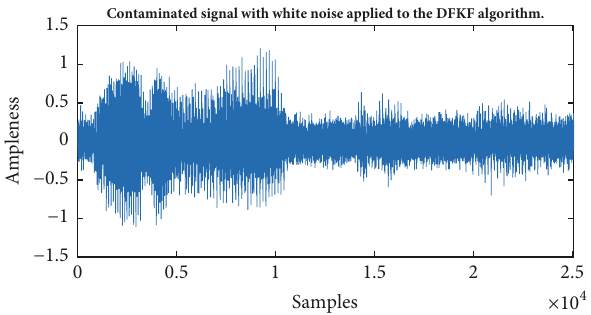
Figure 4: Contaminated signal with white noise applied to the algorithm DFKF.